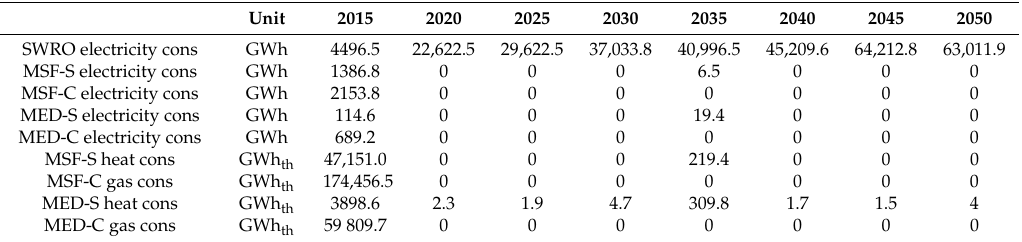
Table 10. Energy Consumption of the desalination technologies during the transition. Unit